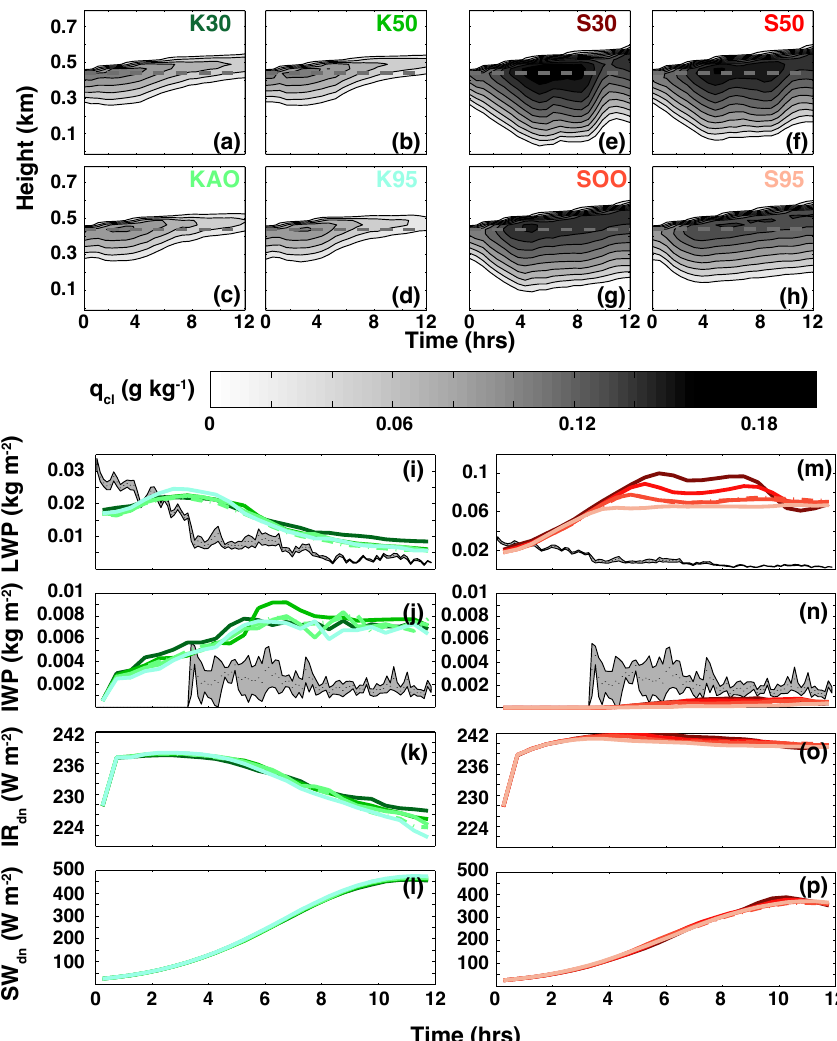
Fig. 8. Domain-averaged time-height cross sections of cloud water mixing ratio for Kaolinite (a–d) and Soot (e–f) simulations with different assumed soluble mass fractions. Included below are time series of domain-averaged mean liquid water path (i, m) , ice water path (j, n) , surface downwelling infrared radiation (k, o) and surface downwelling shortwave radiation (l, p) for the Kaolinite (left) and Soot (right) simulations with different soluble mass fraction assumptions. Observations are represented by the dotted line (mean) and grey shading (standard